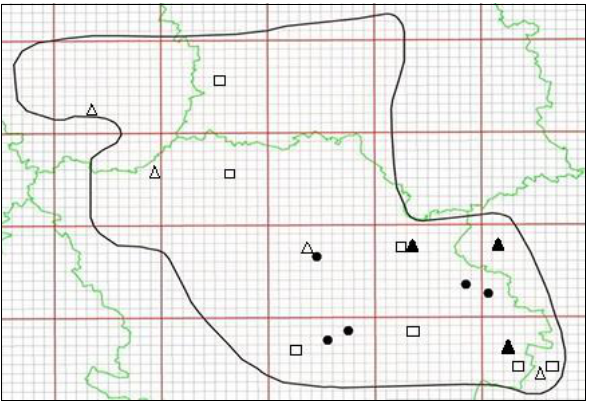
Fig. 8. The distribution of selected ephemerophytes in the Romensko-Poltavsky Geobotanical District: A. - Phalaris canariensis L.; B. - Panicum capillare L. subsp. barvipulvinatum (Nash) Tzvelev; C. - Sorghum halepense (L.)